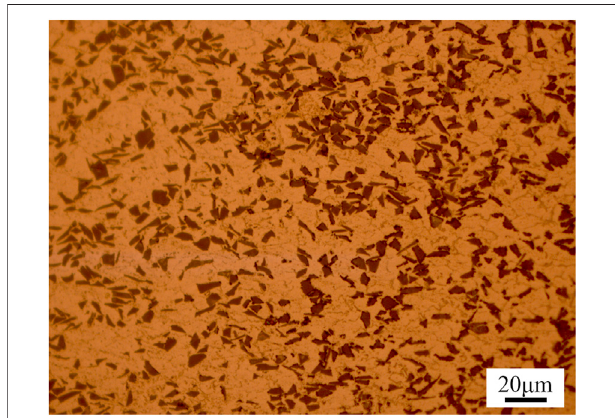
FIGURE 1 | Microstructure of base material.